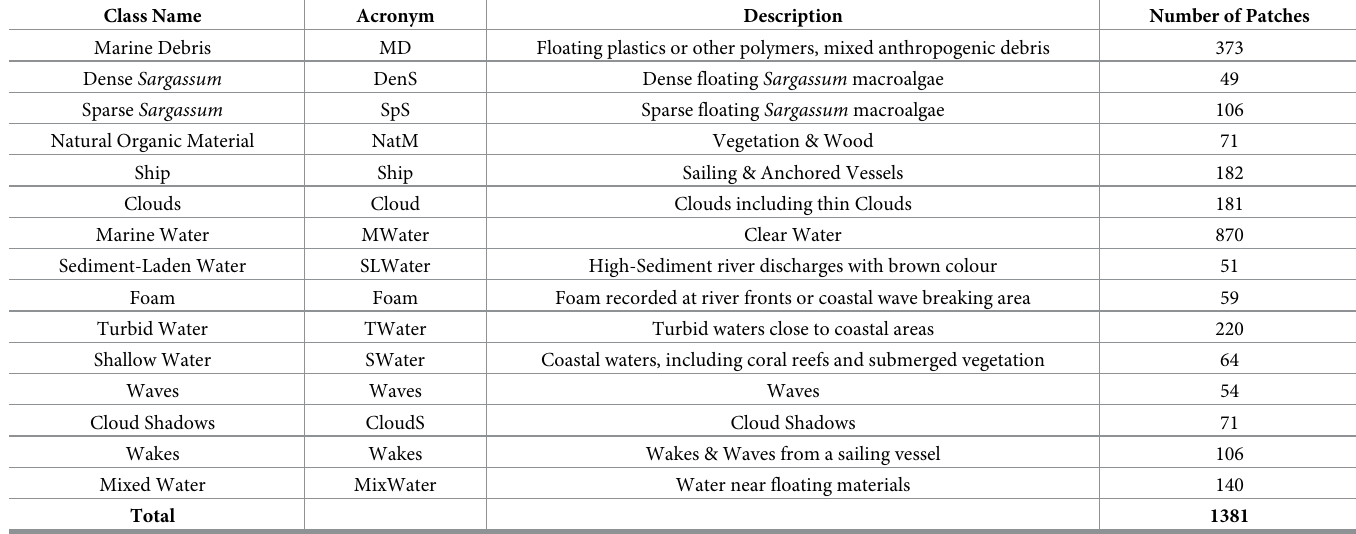
Table 2. The thematic classes of MARIDA. Name, description and corresponding number of patches are presented for each class. All acronyms are stated